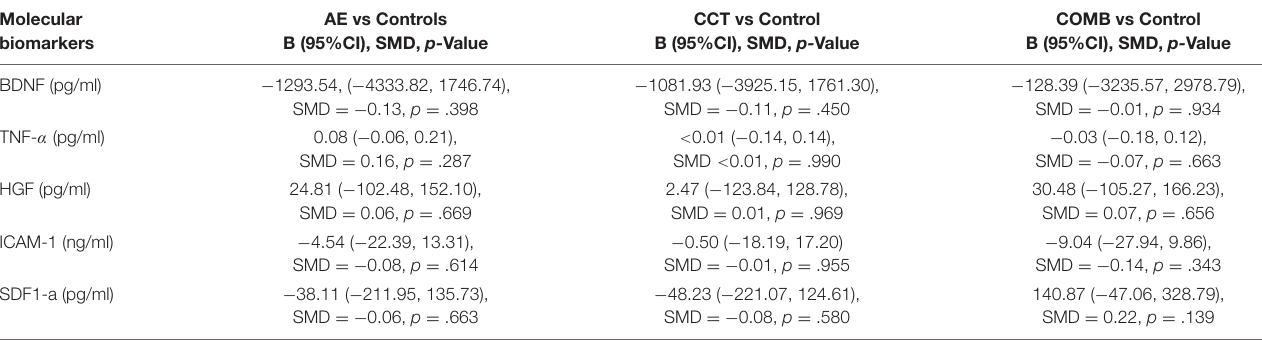
TABLE 3 | Intervention related changes in molecular biomarkers (Level 1). Molecular biomarkers